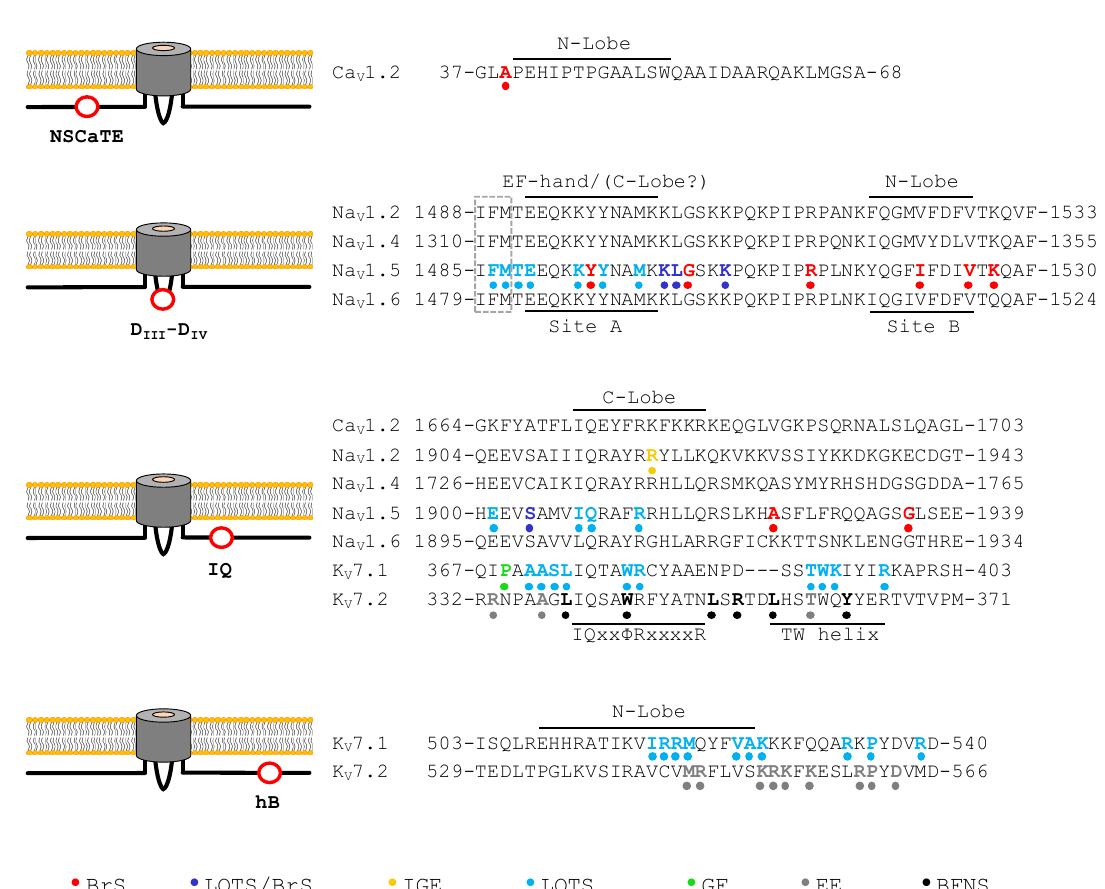
Figure 3. Location of the different mutations found in Ca V 1, Na V 1, and K V 7 channel CaMBD that lead to channelopathies. Left: schematic overall location of different CaMBD (red circle). Note that K V 7 channels have four IQ/helix A and helix B domains (See Figure 2). NSCaTE (N-terminal spatial Ca 2+ transforming element) is only present in Ca V 1 channels, D III –D IV repeat domain linker CaMBD is only found in Na V 1 channels, the IQ motif (IQ) is present in all of them and helix B (hB) is only present in K V 7 channels. Right: The IFM inactivation motif of Na V is boxed. The interacting CaM lobe or channel domain is indicated on top of the corresponding sequences. The location of the mutation and the disease linked to each mutation is indicated in the color scheme at the bottom. BrS: Brugada syndrome; LQTS: long QT syndrome; IGE: idiopathic generalized epilepsy; GF: gingival fibromatosis; EE: epileptic encephalopathy; BFNS: benign familial neonatal seizures.